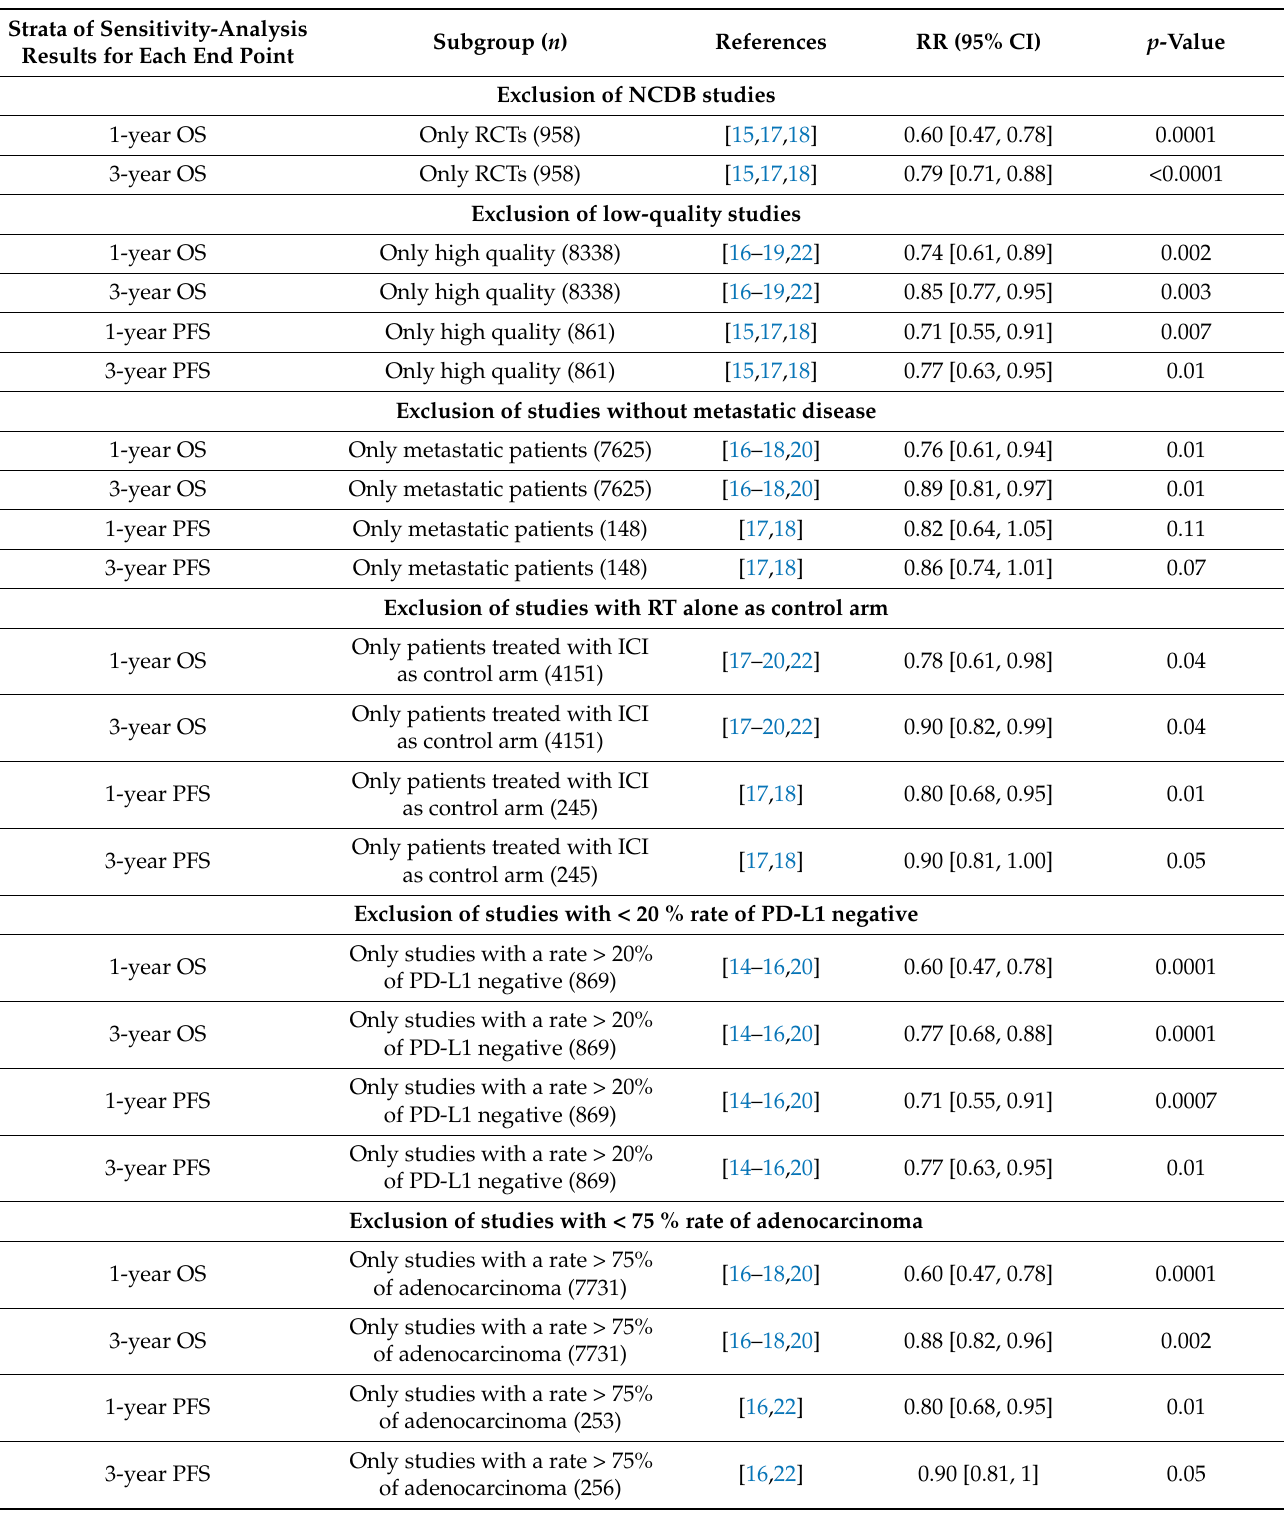
Table 2. Sensitivity